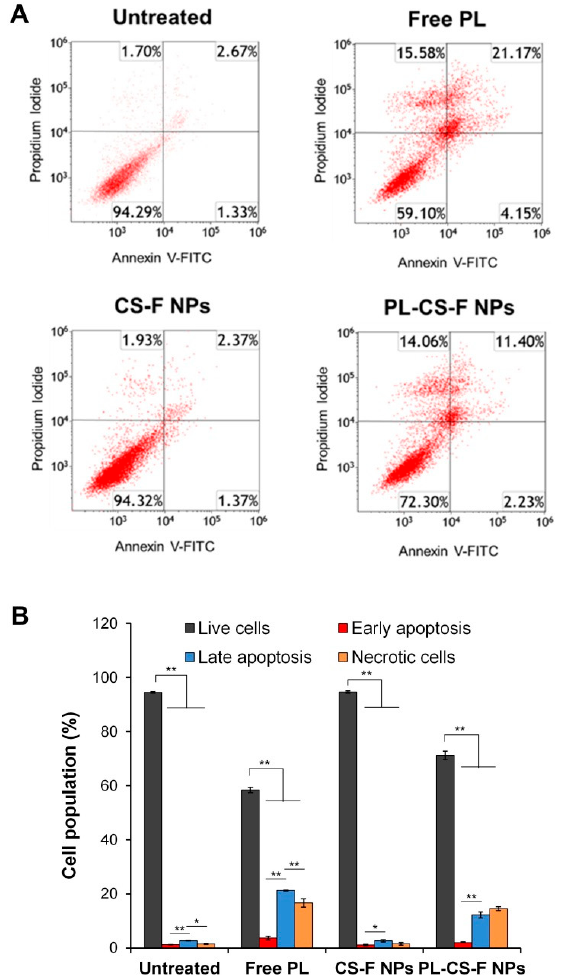
Figure 6. Apoptosis of PC-3 cells treated with PL-CS–F NPs. ( A ) Flow cytometric analysis of PC-3 cells treated with free PL (10 µ M), CS–F NPs, and PL-CS–F NPs (10 µ M PL). ( B ) Quantification of live, early apoptotic, late apoptotic, and necrotic cells from the flow cytometric histograms (* p < 0.05, ** p <